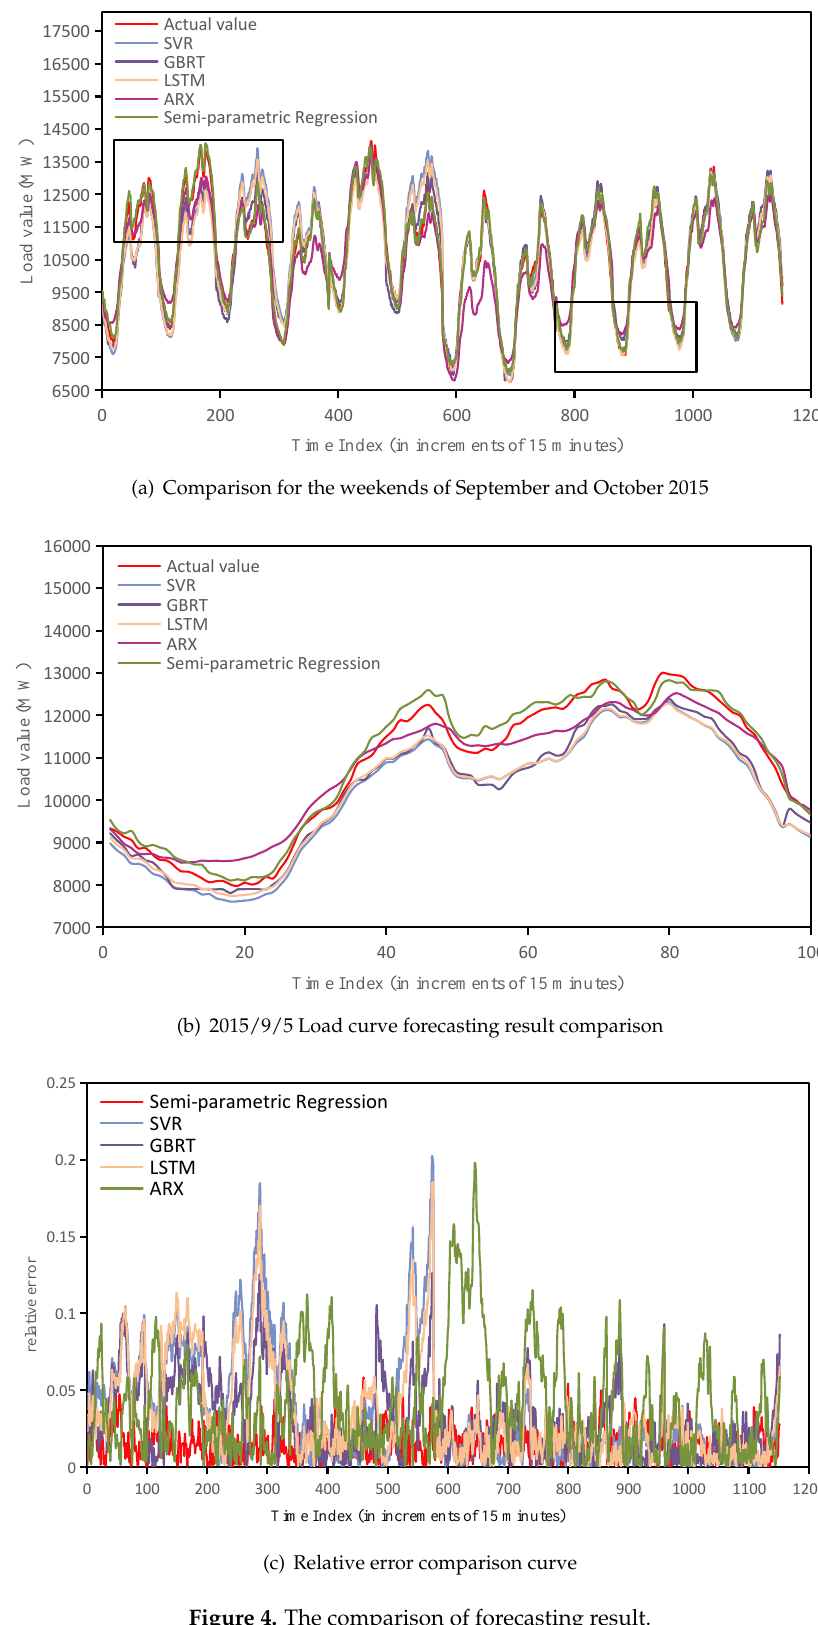
Figure 4. The comparison of forecasting